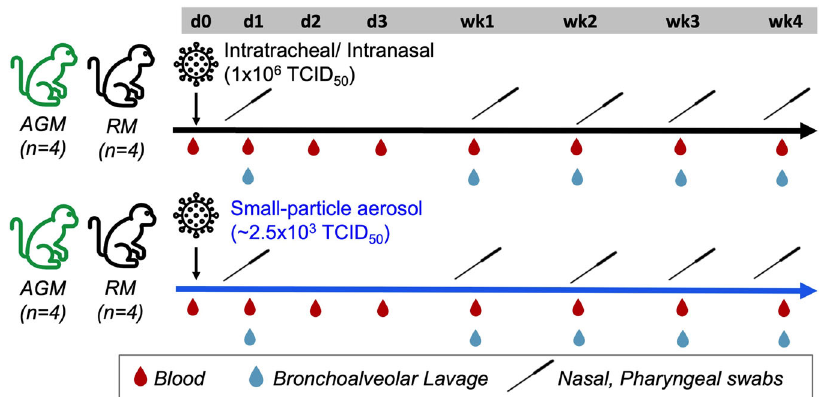
Fig. 1 Study Design. Rhesus macaques (RM, n = 8) and African green monkeys (AGM, n = 8) were split into 4/group and inoculated with SARS-CoV-2 via either intratracheal/intranasal (IT/IN) route or aerosol route Serial collections of blood, bronchoalveolar lavage, and swabs of the nasal and pharyngeal cavities were taken at several study timepoints, including d0, d1, d2, d3, wk1, wk2, wk3, and wk4